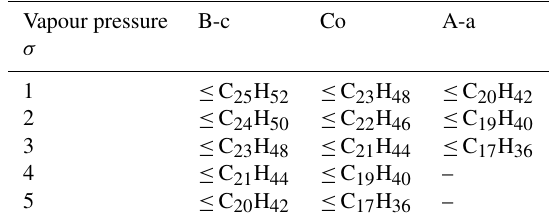
Table 2. Modal composition ranges and composition standard de- viations, σ , producing model results that approximate REPARTEE- like behaviour (see main text), for different vapour pressure param- eterisations. Initial non-volatile core in the nucleation mode is set to